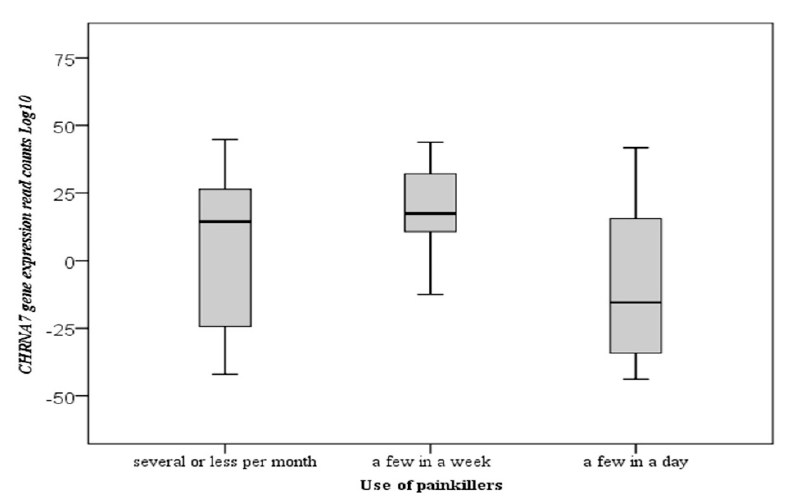
Figure 3. Boxplot of the CHRNA7 gene expression for use of painkillers according to Dunn’s multiple comparison test results. The total numbers of mRNA reads are log10